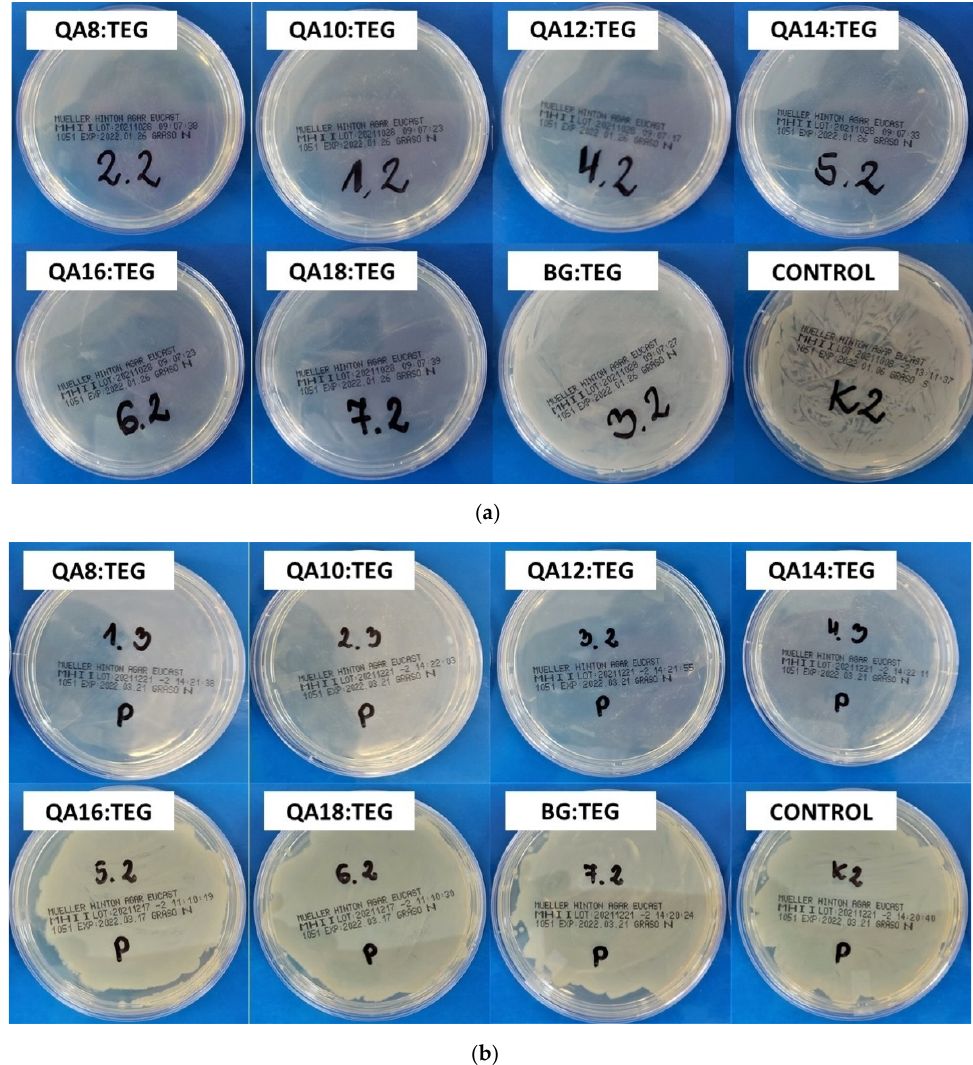
Figure 8. Images of the bacteria colonies ( a ) S. aureus (ATCC 25923) and ( b ) E. coli (ATCC 25922) that grew at the copolymer concentrations of 25 mg/mL.